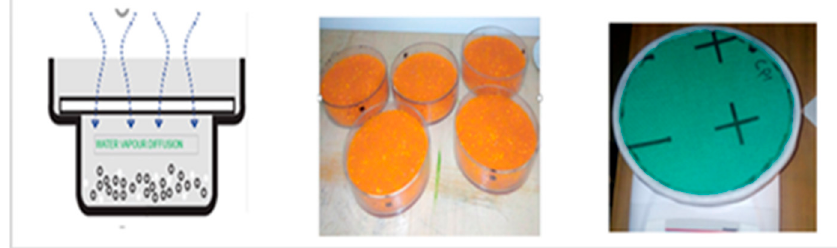
Figure 17. Wet-cup test method.